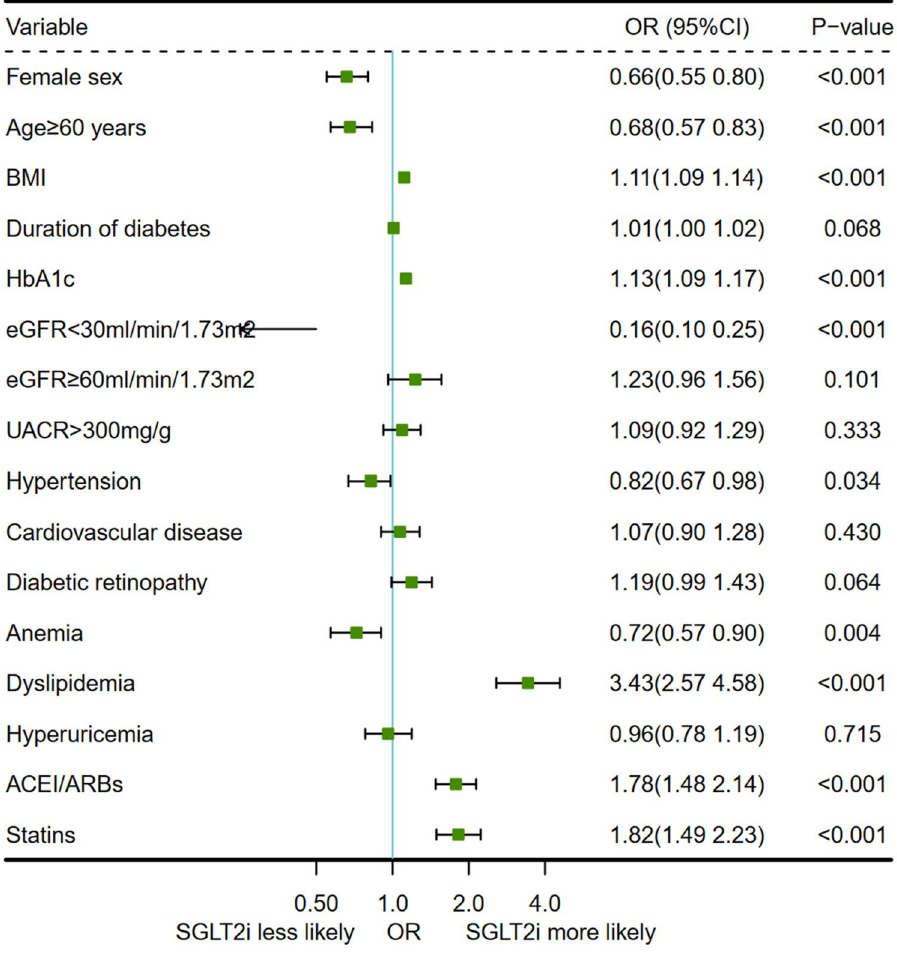
Figure 7. Factors influencing the use of SGLT2 inhibitor. SGLT2i, sodium–glucose cotransporter 2 inhibitor; BMI, body mass index; HbA1c, glycosylated hemoglobin; eGFR, estimated glomerular filtration rate; UACR, urine albumin creatine ratio; CVD, cardiovascular disease; ACEI/ARBs, angiotensin converting enzyme inhibitors/angiotensin receptor